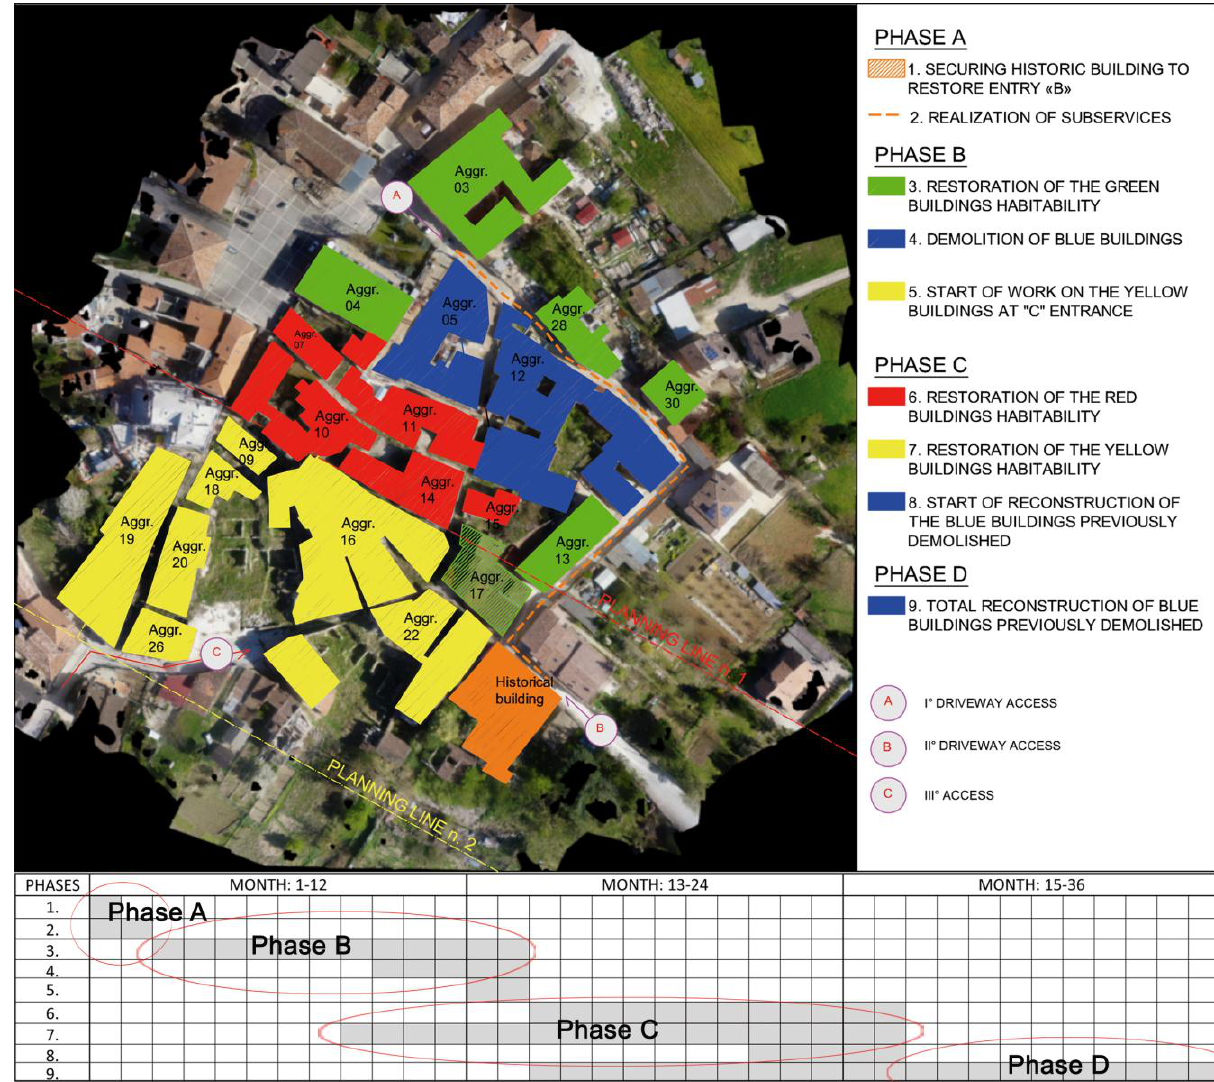
Figure 8: The reconstruction plan of Villa Sant’Angelo. Phases and time